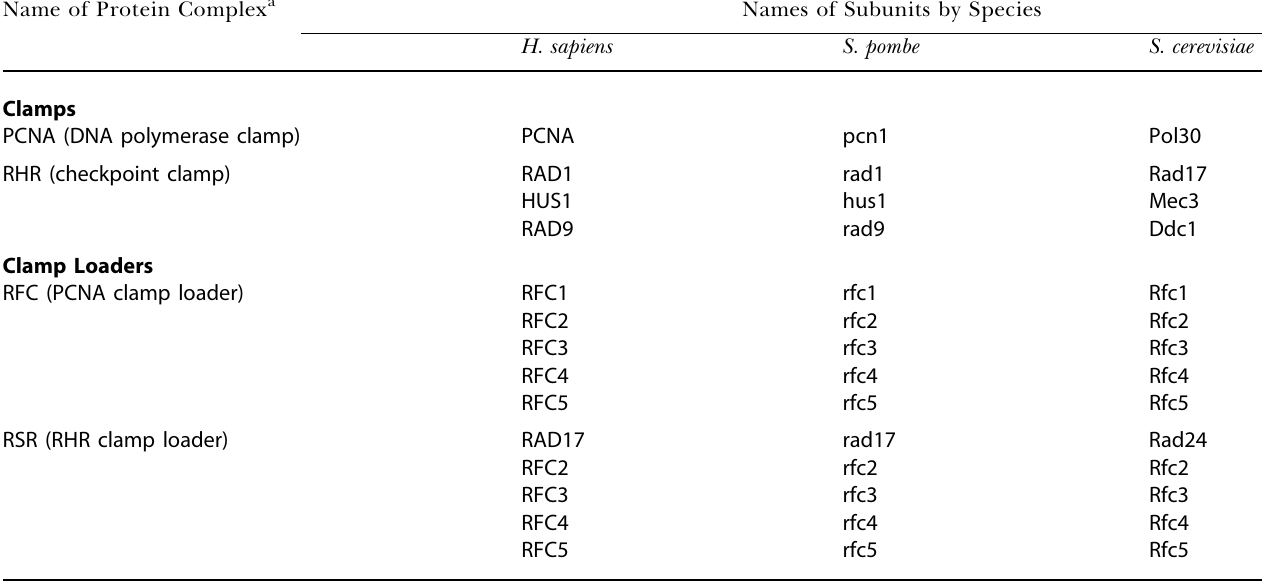
Table 1. Clamp and Clamp Loader Protein Complexes Name of Protein Complex